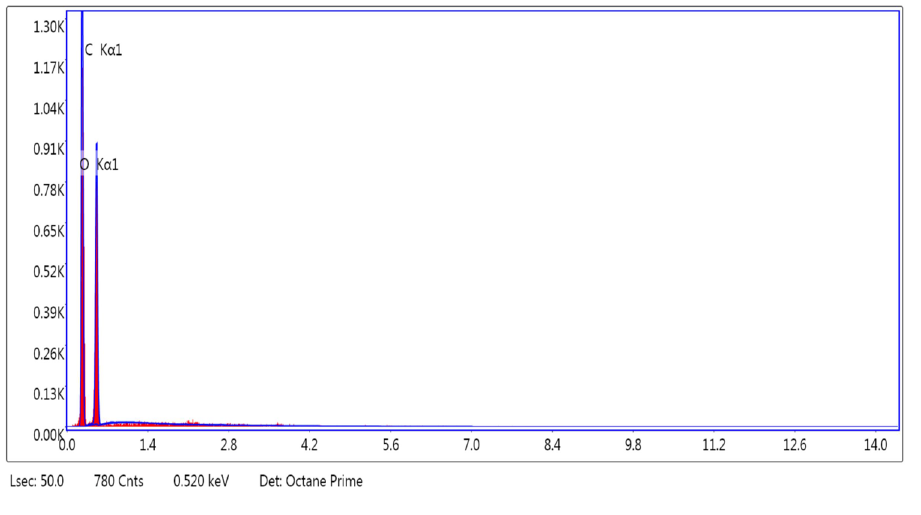
Figure 11. EDX results of CTF